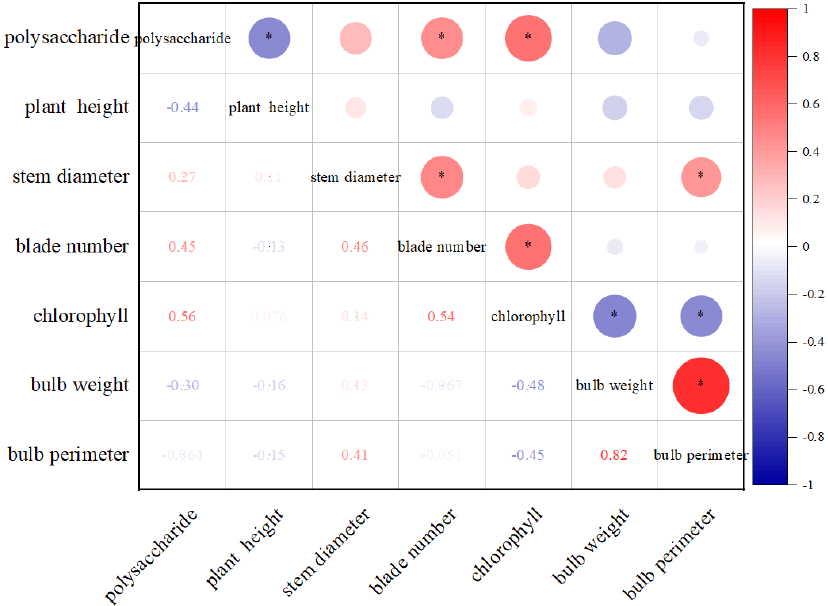
Figure 2. Correlations between agronomic traits and polysaccharide contents of L . davidii var. unicolor . * represents correlation ( p ≤ 0.05): red is positive correlation, blue is negative correlation. K concentrations comprising K 0 (0 mg ∙ L − 1 ), K 1 (447.6 mg ∙ L − 1 ), K 2 (671.4 mg ∙ L − 1 ), or K 3 (895.2 mg ∙ L − 1 ). Samples were taken every 15 days after potassium application.